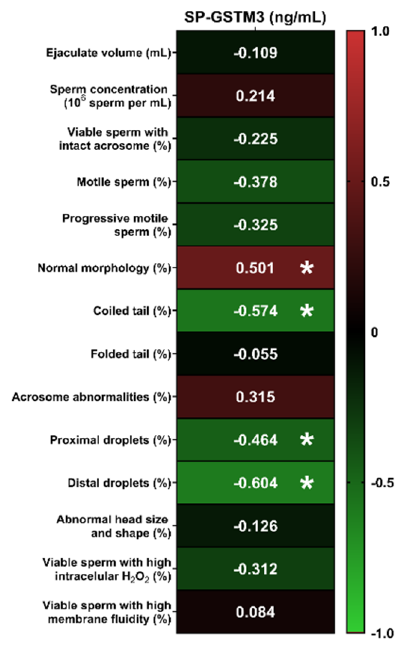
Figure 2. Heatmap of Pearson correlation coefficients between pig seminal plasma GSTM3 (SP-GSTM3) concentrations (ng/mL) and sperm quality and functionality parameters assessed in semen samples immediately after ejaculation ( n = 20). * p < 0.05.